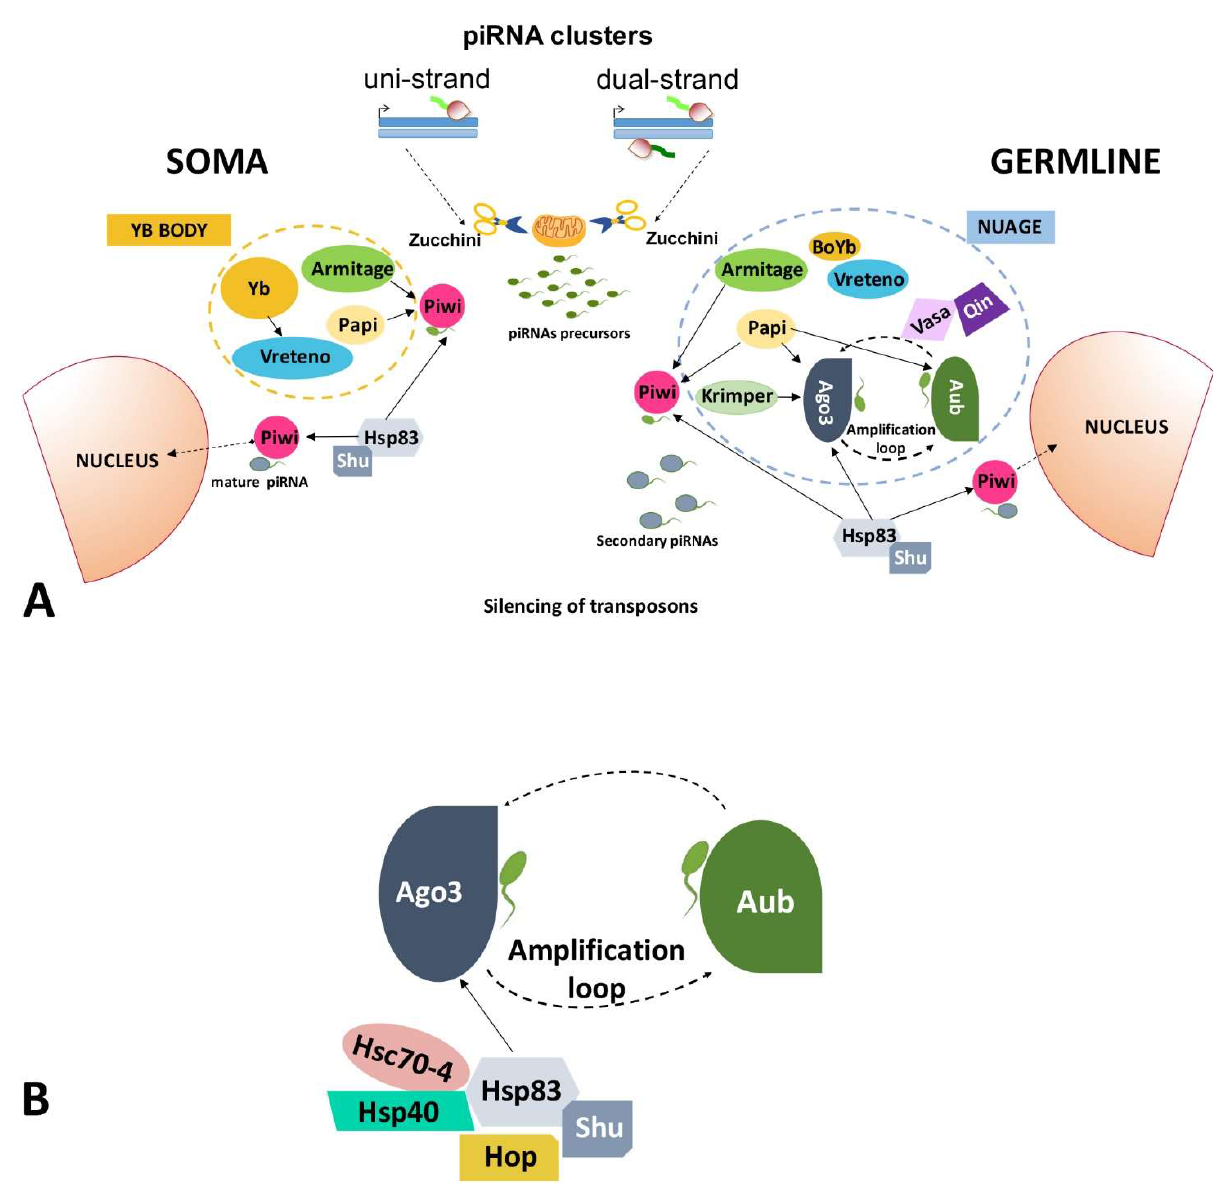
Figure 1. Scheme of the proteins implicated in the piRNA pathway in gonads. ( A ) Proteins involved in the gonadal piRNA are shown. The Yb body in the soma and the nuage in the germline are indicated. Arrows with a continuous line mark the interactions amongst the proteins in the soma (on the left) and in the germline (on the right). ( B ) Details of HSP83-cochaperones complex involved in the piRNA-mediated silencing of transposable elements in the germline . Table 1. List of genes involved in the piRNA pathway and reported in Figure 1, with the hortologs in humans, their protein domains, and functions. The references refer to the involvement of the reported genes in the piRNA pathway.